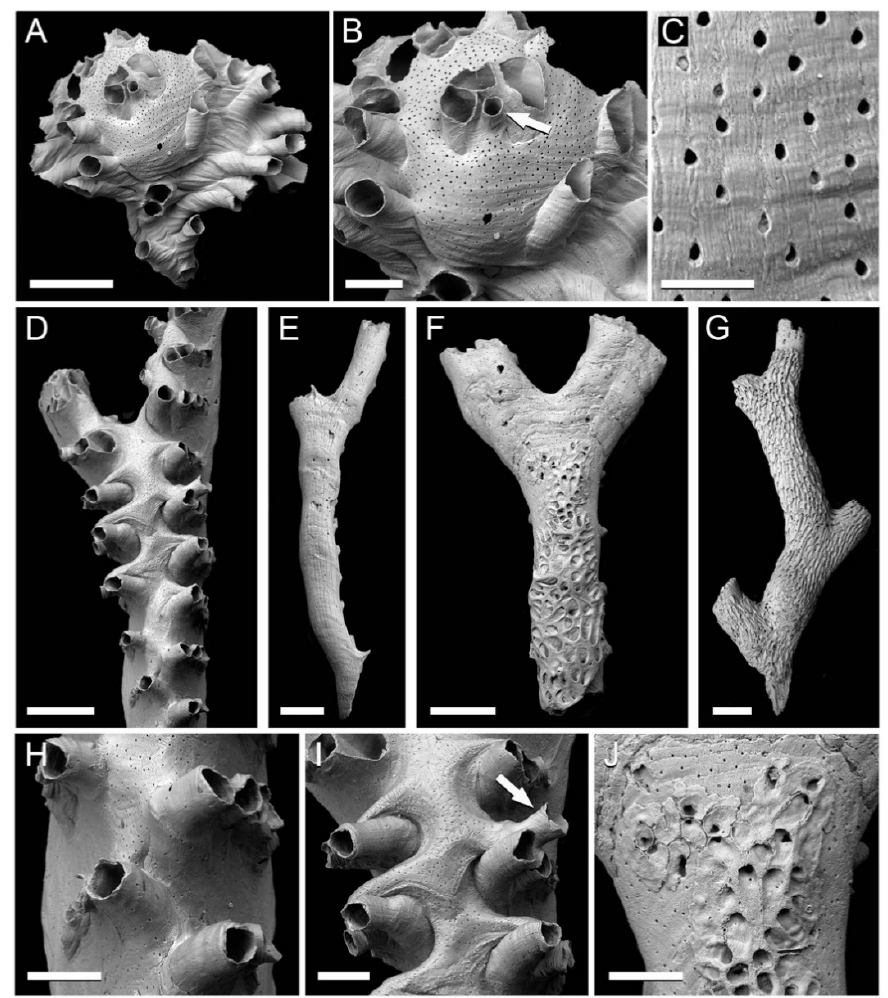
Figure 2. Cyclostome bryozoans from the Clyde Clay Formation of Garvel Park, Greenock, Scot- land. ( A – C ) Tubulipora cf. marisalbi Gostilovskaja, 1955, NHMUK B1223e; ( A ) entire specimen; ( B ) gonozooid with ooeciostome arrowed; ( C ), pseudopores on frontal surface of gonozooid. ( D – J ) Idmidronea atlantica (Forbes in Johnston, 1847); ( D , H , I ) fertile branch, NHMUK B1223a; ( D ) gonozooid occupying branch axis; ( H ) detail of autozooids on frontolateral sides of branch; ( I ) part of gonozooid with ooeciostome arrowed; ( E ) abfrontal surface of branch lacking kenozooidal overgrowth,